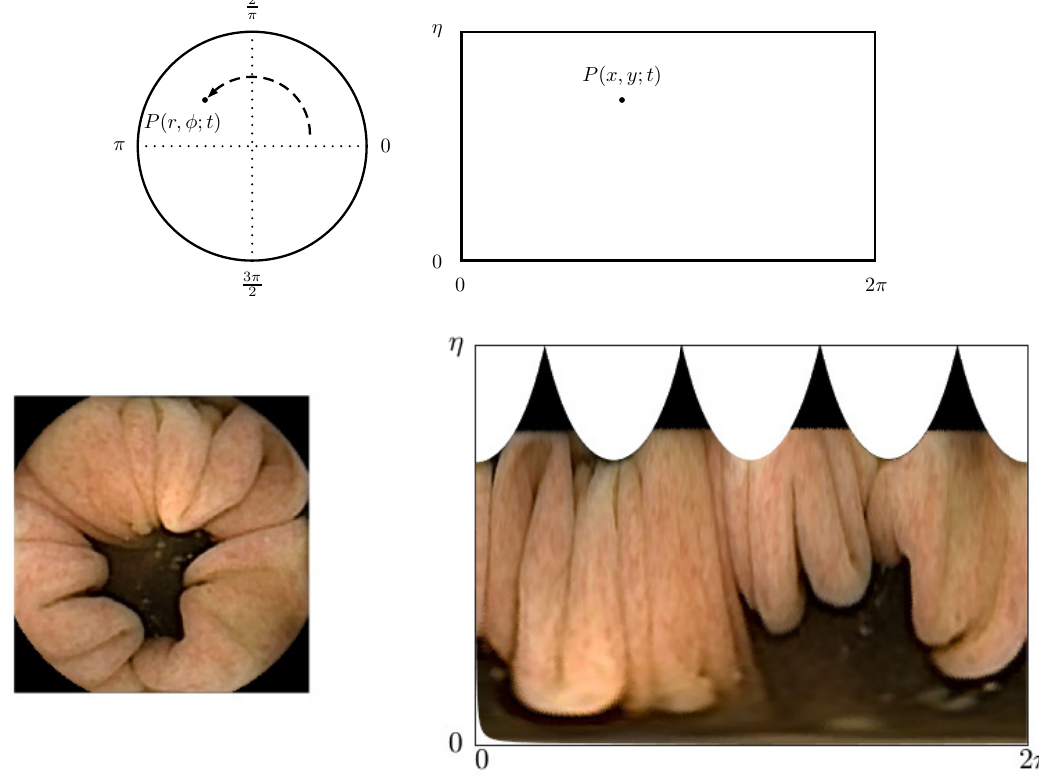
Figure 2. ( Top ) From left to right: Schematic drawing of the frame captured on the CMOS in polar coordinates and transformed frame into Cartesian coordinates. ( Bottm ) From left to right: Actual frame as captured by the CMOS and actual frame as seen when transformed into Cartesian